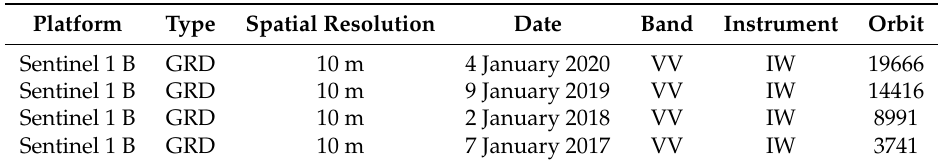
Table 1. Data Collection for Inundation Area